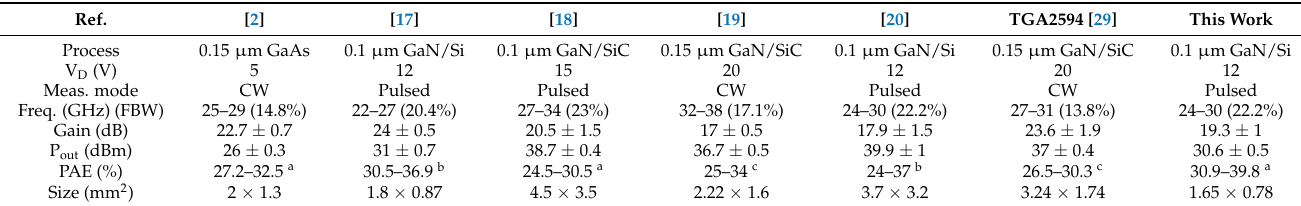
Table 4. Performance summary and comparison with contemporary